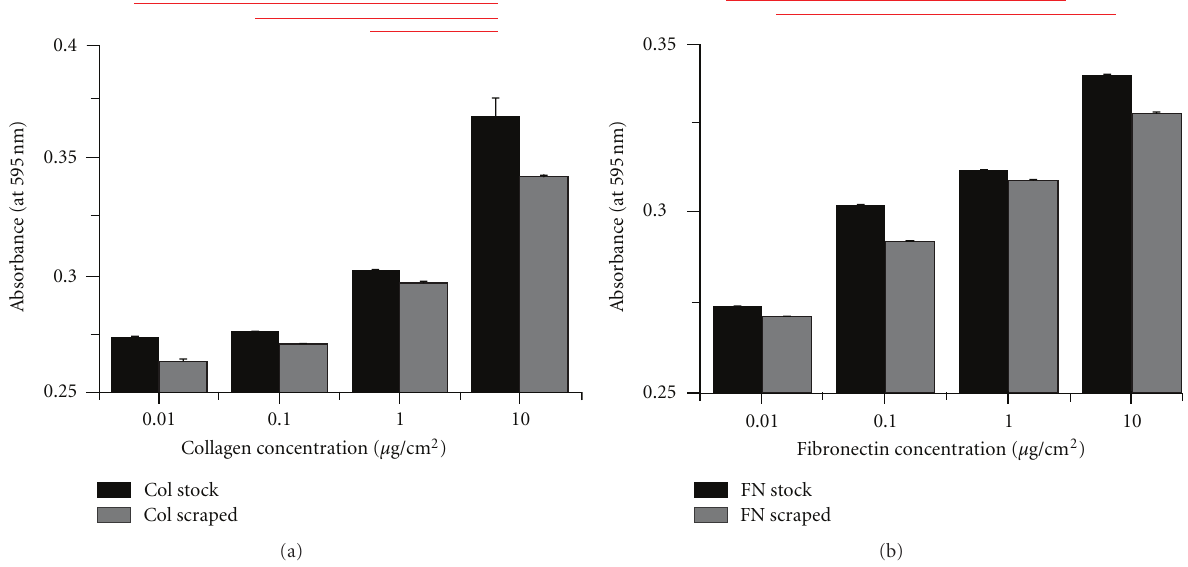
Figure 1: Quantification of ECM surface adsorption at di ff erent densities. Surface adsorption of collagen and fibronectin at di ff erent densities was quantified using UV spectrophotometer (Perkin Elmer). Surfaces were incubated with stock solutions of collagen and fibronectin at the theoretical densities of 0.01, 0.1, 1.0, and 10.0 μ g/cm 2 , respectively, overnight at 4 degrees. The surface-adsorbed ECM protein at di ff erent densities were extracted and quantified to determine the amount of attached protein. The absorbance values of the stock solutions (grey bars) were compared with those of the adsorbed solutions (black bars) at di ff erent densities. While higher absorbance values were obtained for higher ECM density, similar absorbance values between stock solutions and adsorbed solutions at di ff erent densities indicate > 90% adsorption across all the di ff erent conditions. Bars indicate statistical significance ( ∗ P < 0 .